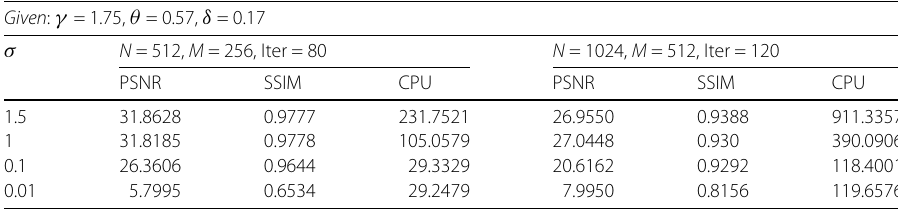
Table 7 Computational results for each σ